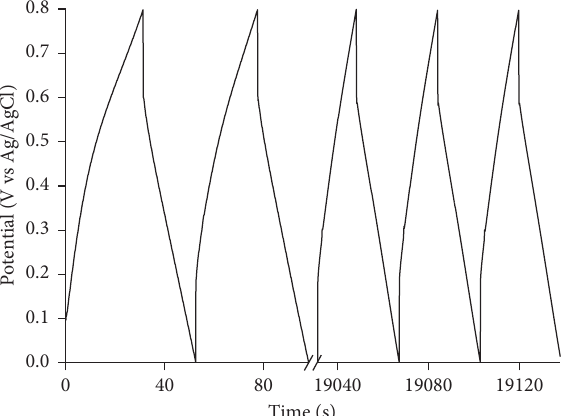
Figure 9: The first two and last three cycles of the GCD plots of the PANI/GO/Azo composite measured in the 500 times repeated charge- discharge processes, measured at a current density of 4 Ag − 1 .